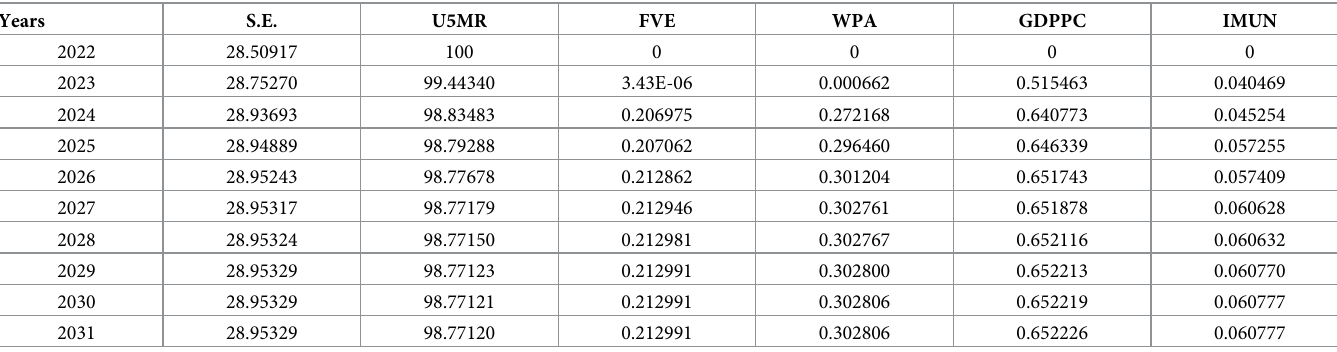
Table 6. Variance decomposition of